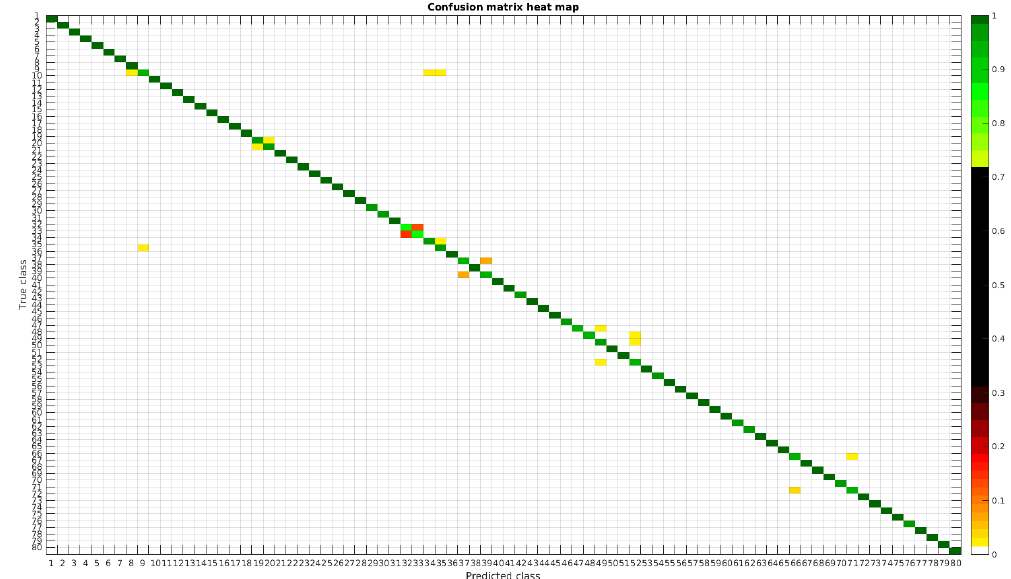
Figure 10. Confusion matrix heat map for the segmented dataset with 700 samples per